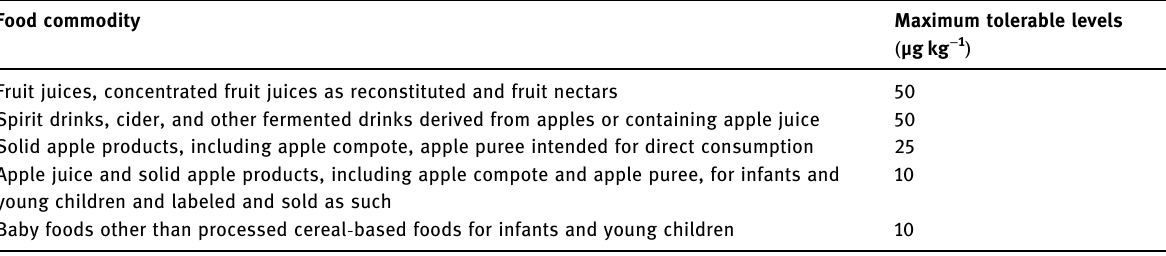
Food commodity Maximum tolerable levels